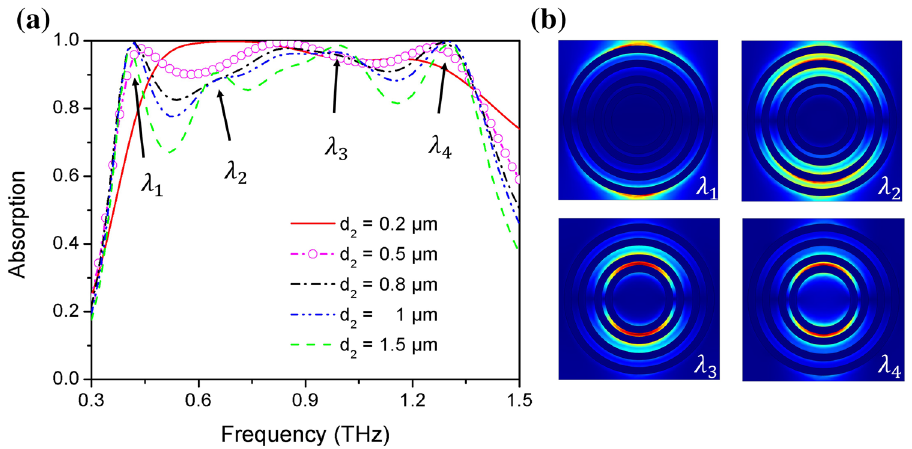
Figure 3. ( a ) Absorption spectra as a function of thickness of VO 2 rings. ( b ) Electric field distributions at the four absorption peaks in the MMVA layer.